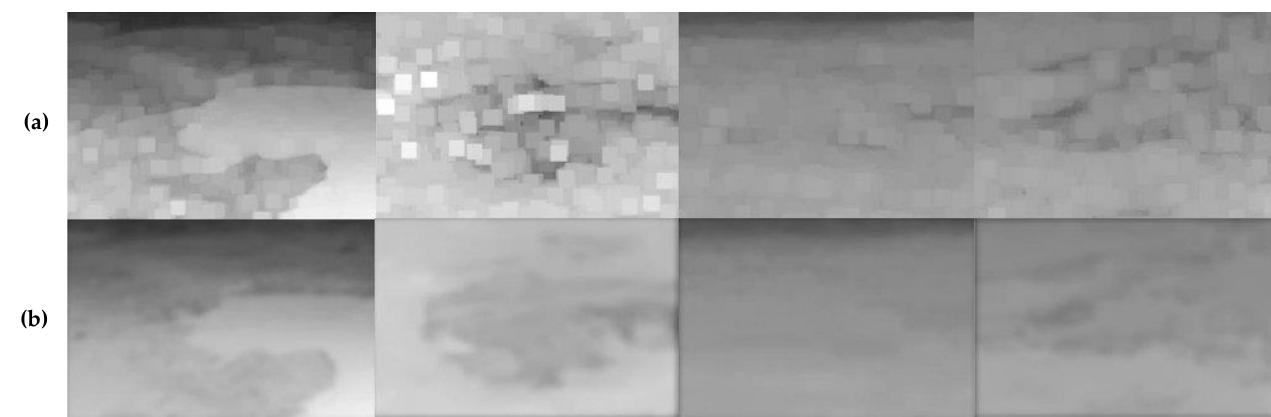
Figure 5. Detailed images of Figure 4: ( a ) original hazy image, ( b ) Tarel and Hautiere [35] method, ( c ) He et al. [40] method, and ( d ) proposed method.